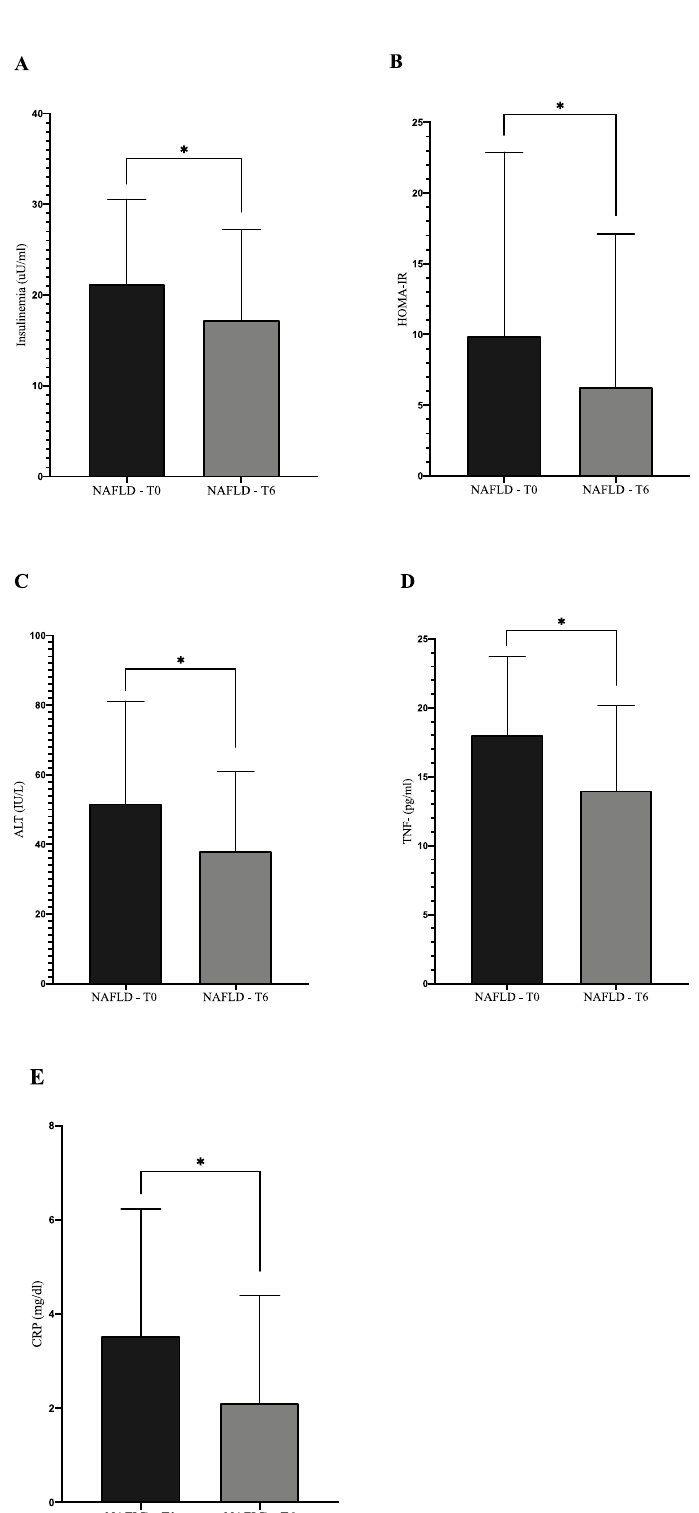
Figure 2. Effect of Realsil 100D administration on several biochemical indices in NAFLD patients. All the evaluated parameters showed a statistically significant improvement at the end of therapy in comparison to the baseline (* p < 0.05). NAFLD: non-alcoholic fatty liver disease; HOMA-IR: Homeostatic Model Assessment of Insulin Resistance; ALT: alanine aminotransferase; TNF- α : tumor necrosis factor alpha; CRP: C reactive protein. ( A ) Insulinemia, ( B ) HOMA-IR, ( C ) ALT, ( D ) TNF, ( E )